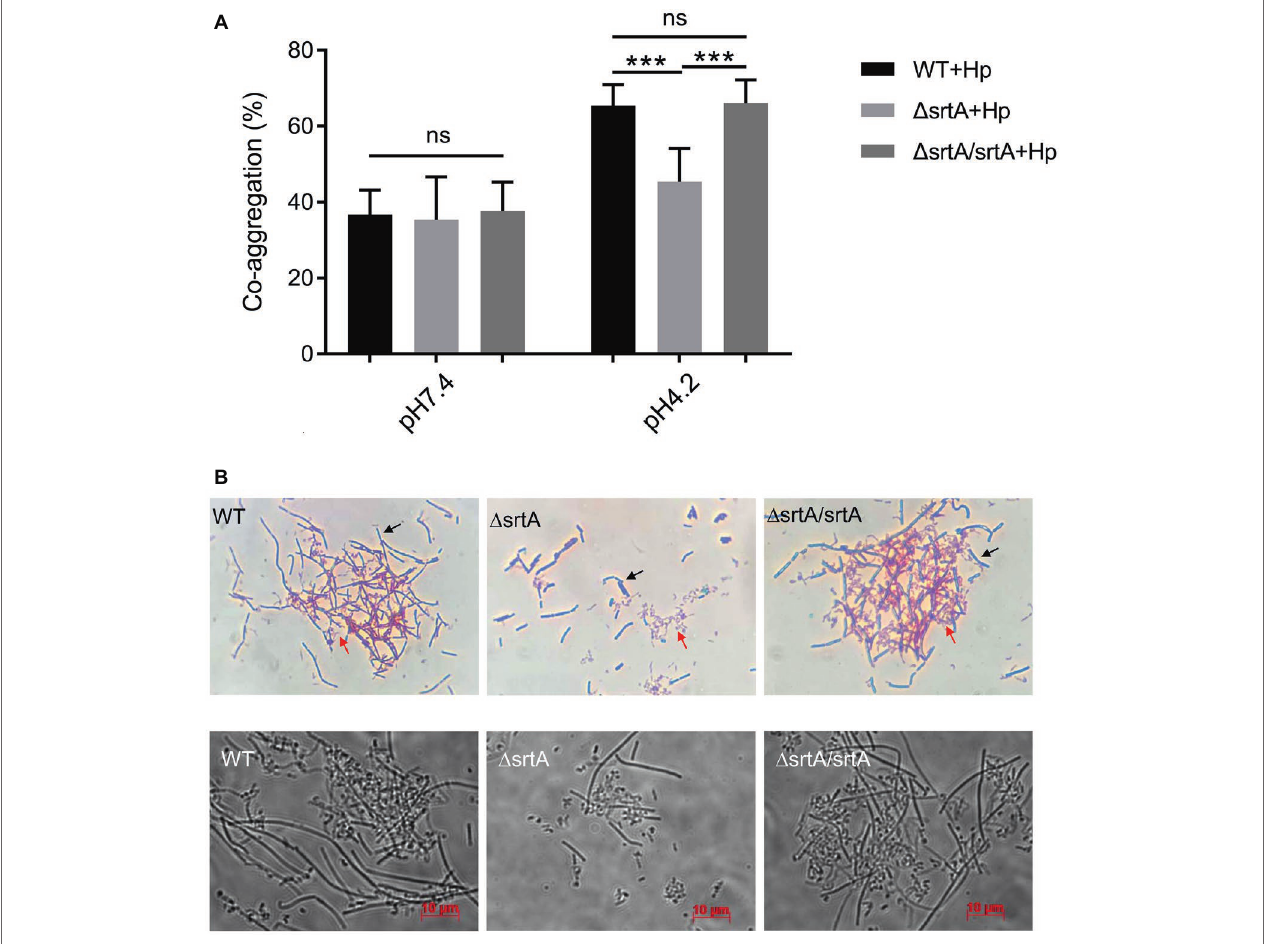
FIGURE 4 | SrtA contributes to the coaggregation of L. gasseri Kx110A1 with H. pylori 67:21. (A) . Coaggregation of L. gasseri Kx110A1 with H. pylori 67:21 at pH 7.4 and pH 4.2. (B) The coaggregates were Gram-stained and subsequently observed under a light microscope at 100× (upper panel) or directly observed under a live-cell microscope (lower panel). Representative images are shown. The black arrow indicates lactobacilli, and the red arrow indicates H. pylori . Data represent the means ± SD of three independent experiments, *** p < 0.001, ns, no